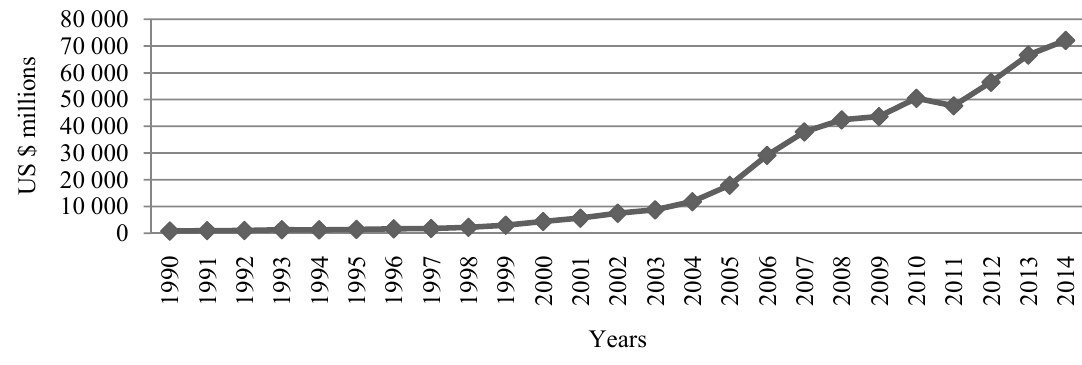
Fig. 1. Islamic financial investments in UAE